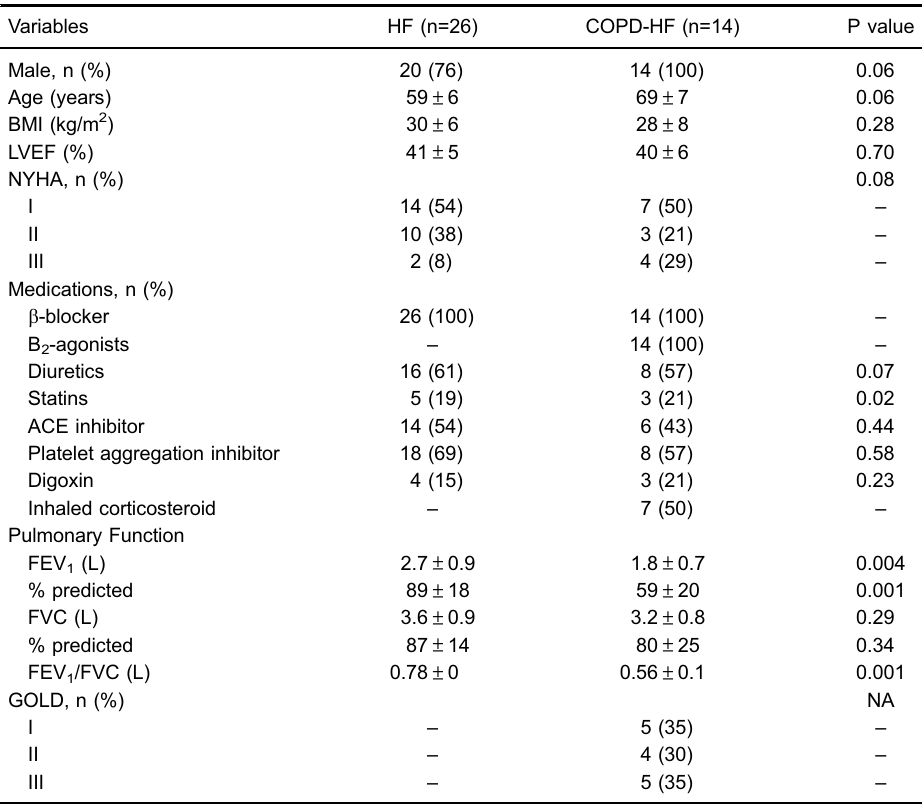
Table 1. Clinical, echocardiogram, and spirometry ’ s characteristics in heart failure (HF) patients and chronic obstructive pulmonary disease-heart failure (COPD-HF) patients.